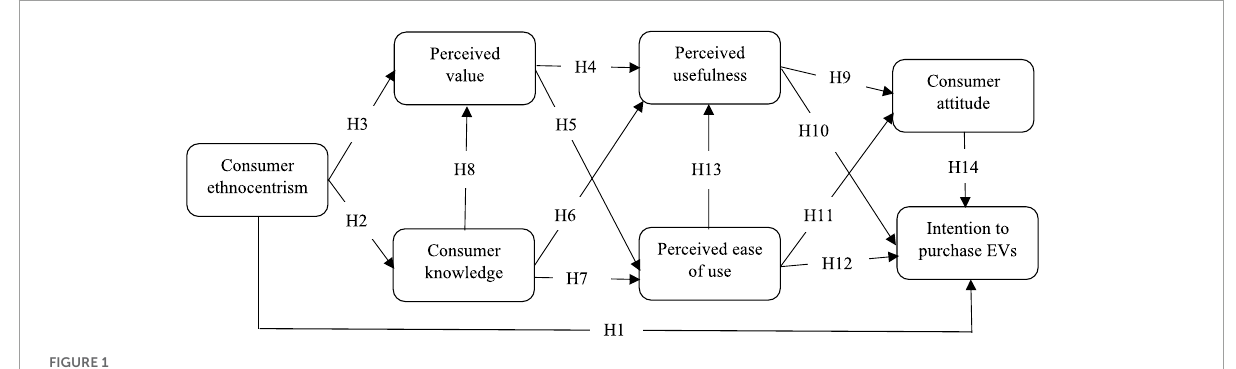
FIGURE1 Conceptual research